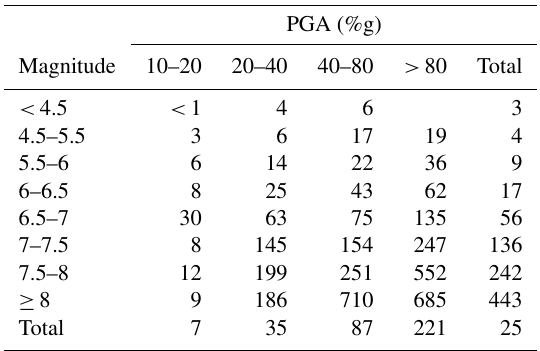
Table 3. Average area in 100km 2 exposed to at least 10%g PGA, by magnitude and maximum PGA